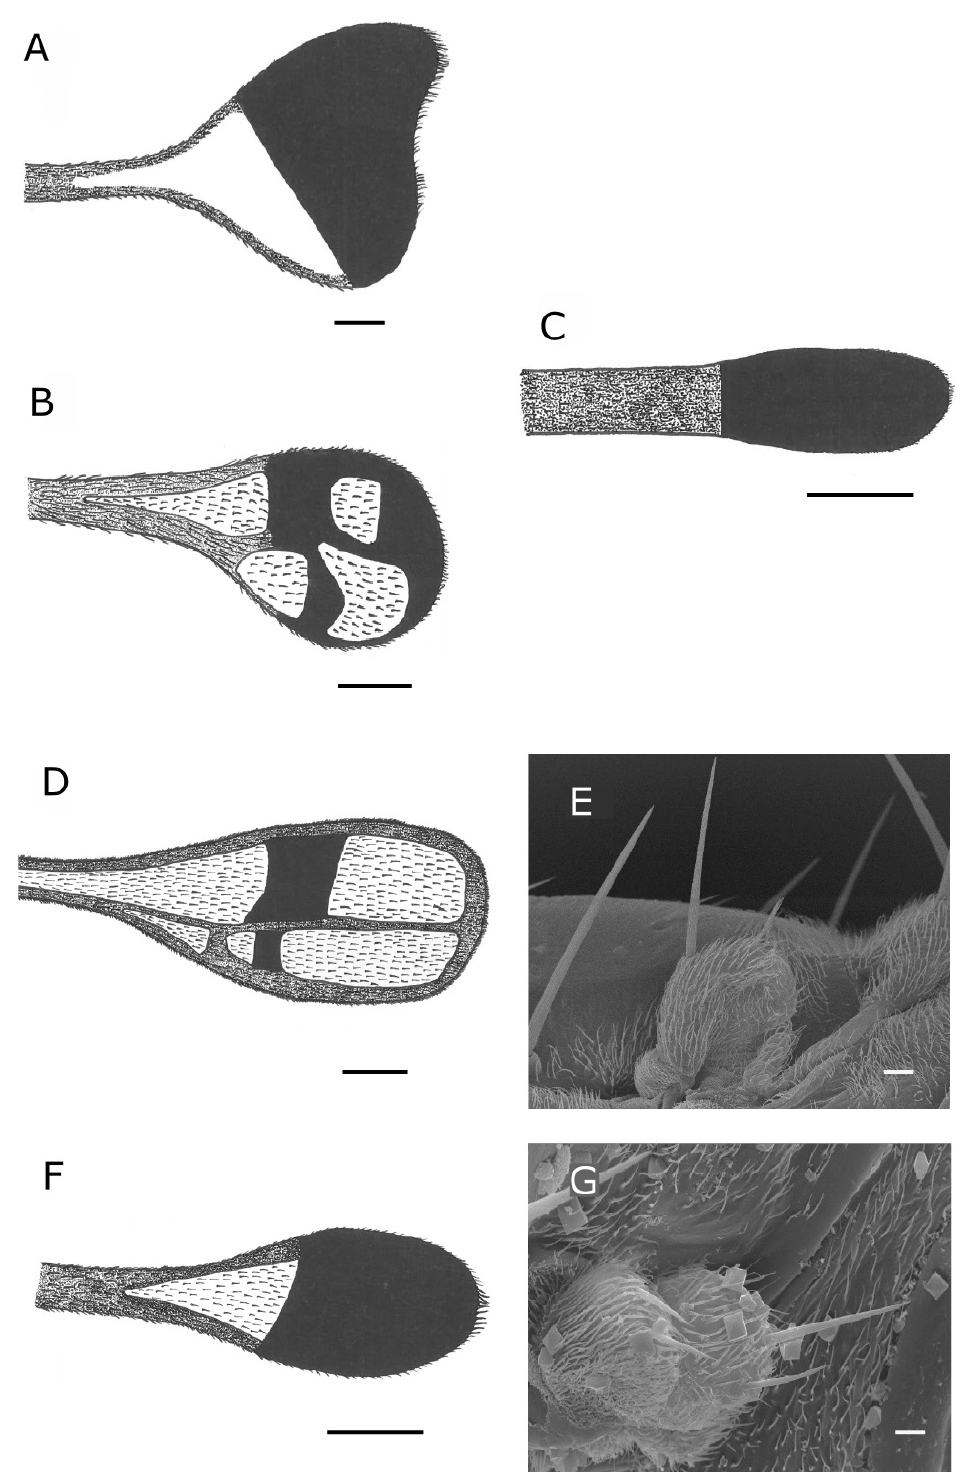
Fig. 21. Drawings of the tip of stenopterous wings and images obtained by scanning electron microscope (SEM) of the micropterous wings. Males are pictured in the left column, females in the right. A, C . T. pandellei (Séguy, 1941). B–C . T. pieltaini (Gil Collado, 1936). D–E . T. semiaptera (Gil Collado, 1923). F–G . T. stenoptera Gonçalves, Grootaert & Andrade sp. nov. Scale bars: A–D, F = 50 µm; E, G = 10